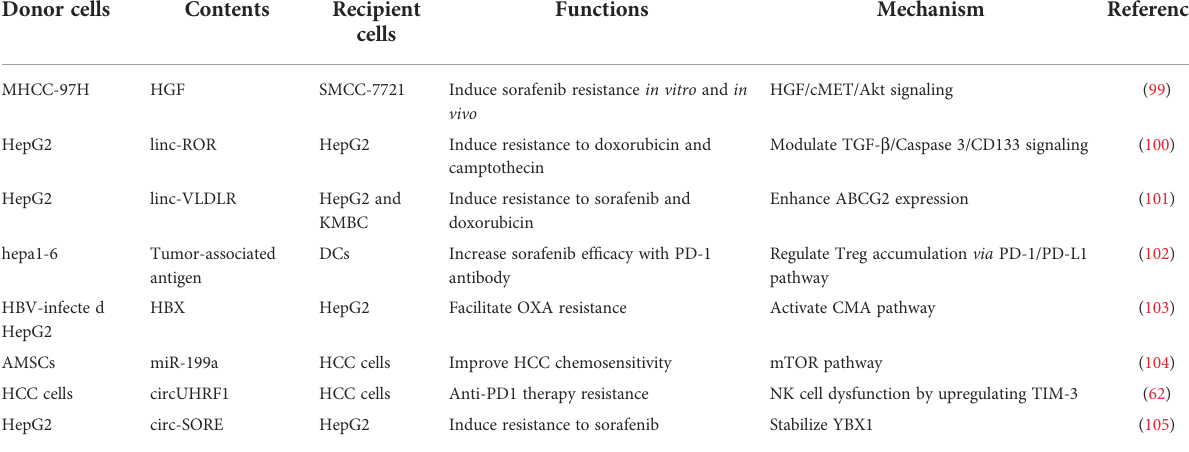
TABLE 2 The role of H-TEXs in liver cancer drug resistance. Donor